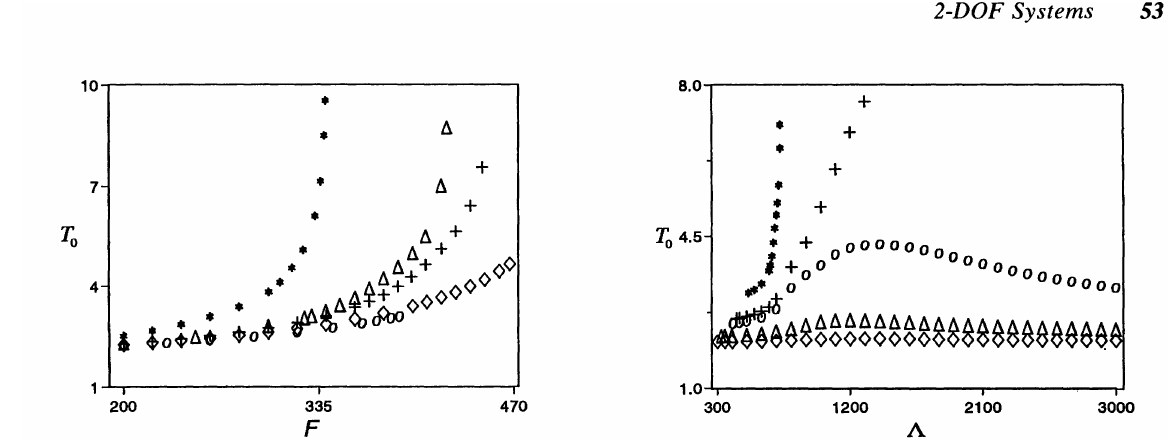
FIGURE 10 Variation of the period of the periodic motion with the aerodynamic detuning. (0) F = 100; (A) F = 200; (0) F = 300; (+) F = 325; (*) F = 400. the limit cycle grows and its period increases, as shown in part (b) for F = 335. At F = Fh = 340.853, the periodic orbit passes through the saddle focus, forming the homoclinic orbit. The eigenvalues of the saddle focus are AI = 0.4656, = -1.2334 ± 4.2036i, and = -2.9324. A2,3 A4 Hence, a = 2.649 > 1. Therefore, according to the Shilnikov theorem, when F < F h , the system has a stable limit cycle, and when F > Fh it has no recurrent behavior, explaining the results in Fig. 9. In Fig. 10, when A increases from approxi-